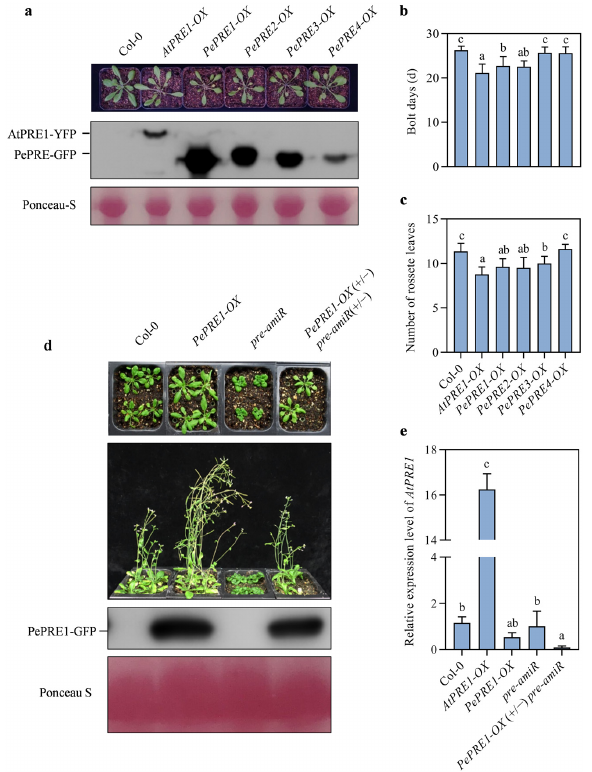
Figure 3. Overexpression of PePRE s promoted plant flowering and growth in Arabidopsis. ( a ) Overexpression of PePRE s in Arabidopsis increased petiole elongation. Panels from top to bottom are pictures of plants grown in soil for 4 weeks (left to right: Col-0, AtPRE1-OX (35S:: AtPRE1-YFP ), and PePREs-OX (35S:: PePREs-GFP )), Western bolt of PRE proteins using GFP antibody, and protein loading control by Ponceau S. Days of bolting ( b ) and rosette leaf numbers ( c ) when plants started bolting. A total of 10 plants were used for calculations. ( d ) Overexpression of PePRE1 suppressed the dwarf phenotype of pre-amiR . Panels from top to bottom are morphology of 4-week-old plants of Col-0, PePRE1-OX , pre-amiR , and PePRE1-OX (+/ − ) pre-amiR (+/ − ), 5-weeks-old plants of Col-0, PePRE1-OX , pre-amiR , and PePRE1-OX (+/ − ) pre-amiR (+/ − ), expression level of PRE1 using GFP antibody, and the protein loading control by Ponceau S. ( e ) Quantitative analysis of AtPRE1 in Col-0, PePRE1-OX , pre-amiR , and PePRE1-OX (+/ − ) pre-amiR (+/ − ). Different letters above the data columns indicate significant differences compared between Col-0 and transgenic lines ( p < 0.05; Duncan’s